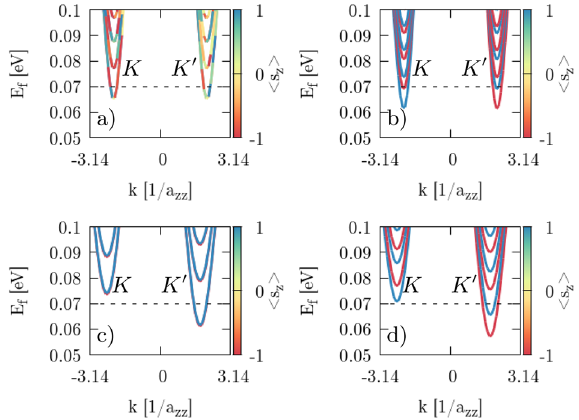
Figure 3. Band structure of silicene nanoribbon with zigzag edges calculated for the center of the QPC 0.15 eV, with NO SOI ( a , c ) and with SOI ( b , d ). Magnetic field is equal to B constriction with V g = 2 T ( c , d ). The black dashed line denotes the Fermi energy E and B z = mean value of the spin projection along z axis. The a zz